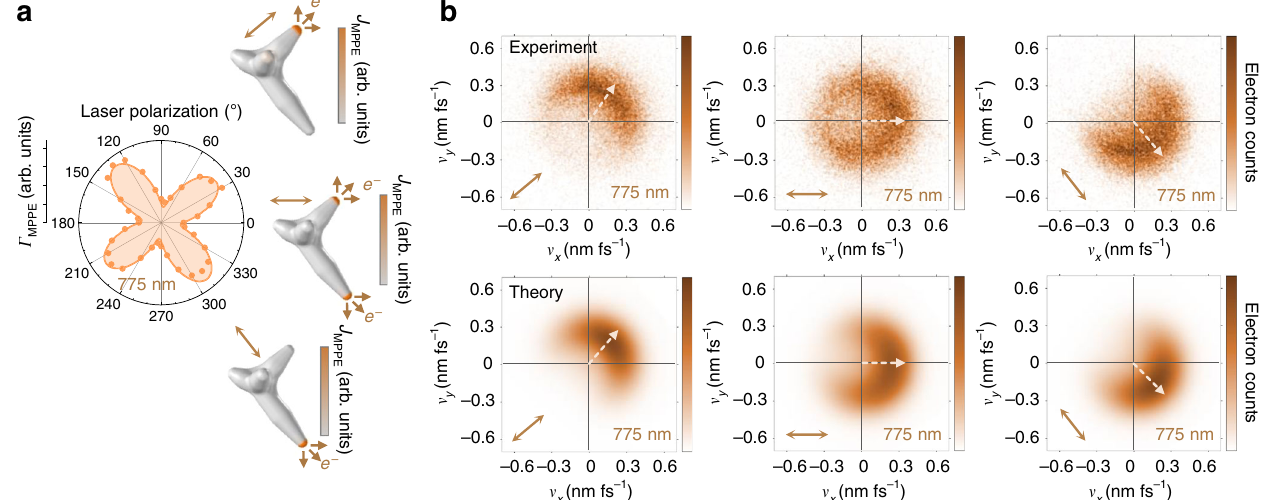
Fig. 5 Polarization-controlled directional photoemission. a Experimental nanostar polarization dependence at 775 nm with nearly equal contributions from both nanostar tip resonances. Tip hot spots are selected by rotating linear polarization while keeping frequency constant, as demonstrated in the calculations on and between the resonances. b Experimental and c theoretical v z -projected velocity maps for the different polarizations at constant frequency. Vectors indicate the peak directions determined by Gaussian fi ts around the peaks of the angular distributions. Peak photoemission angles range from 55° (50°) at 50° linear polarization aligned along the short tip to 310° (315°) at 315° linear polarization aligned along the long tip, for the experimental (theoretical) velocity distributions. The vector magnitude represents the velocity of photoelectrons excited from the Fermi level ( v F ), which remains constant for all distributions due to the fi xed excitation (LF-400) as the mask, enabling particle locating in correlated SEM-SPIM (scanning photoelectron imaging microscopy) studies. The ITO substrates are ultraviolet ozone cleaned to remove hydrocarbons and to permit surface wetting, after which a 50 μ L aliquot of aqueous nanostar solution is spin coated for 5min on the substrate at 1500 r.p.m. The dilution is optimized for a fi nal particle coverage of ~0.05 nanostars μ m − 2 , such that ~20 nanostars can be studied in a 20× 20 μ m 2 SPIM